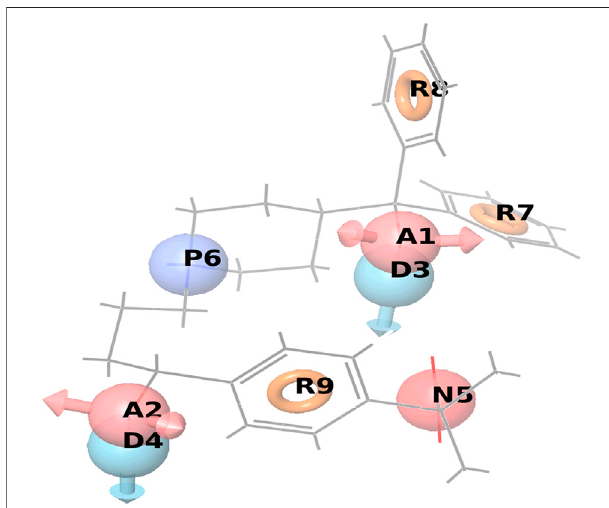
FIGURE9| Representsthecommonpharmacophorehypothesesusing the docking score of screened ligands, where R8 has the most important common pharmacophoric feature that inhibits